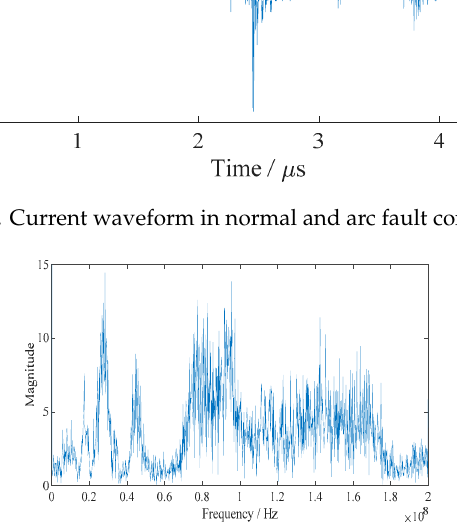
Figure 11. Training results of the CNN. As seen in Figure 11, almost all of the results gather around the value of 0.5 at the beginning. With the amount of training data increasing, the fault data and normal data were separated gradually from each other and the fault data got close to 1, while the normal data clustered together around 0. The green line and the yellow line show the developing tendency of the results, and that the accuracy ratio of the judgement will be improved as more training data are inputted into the CNN.